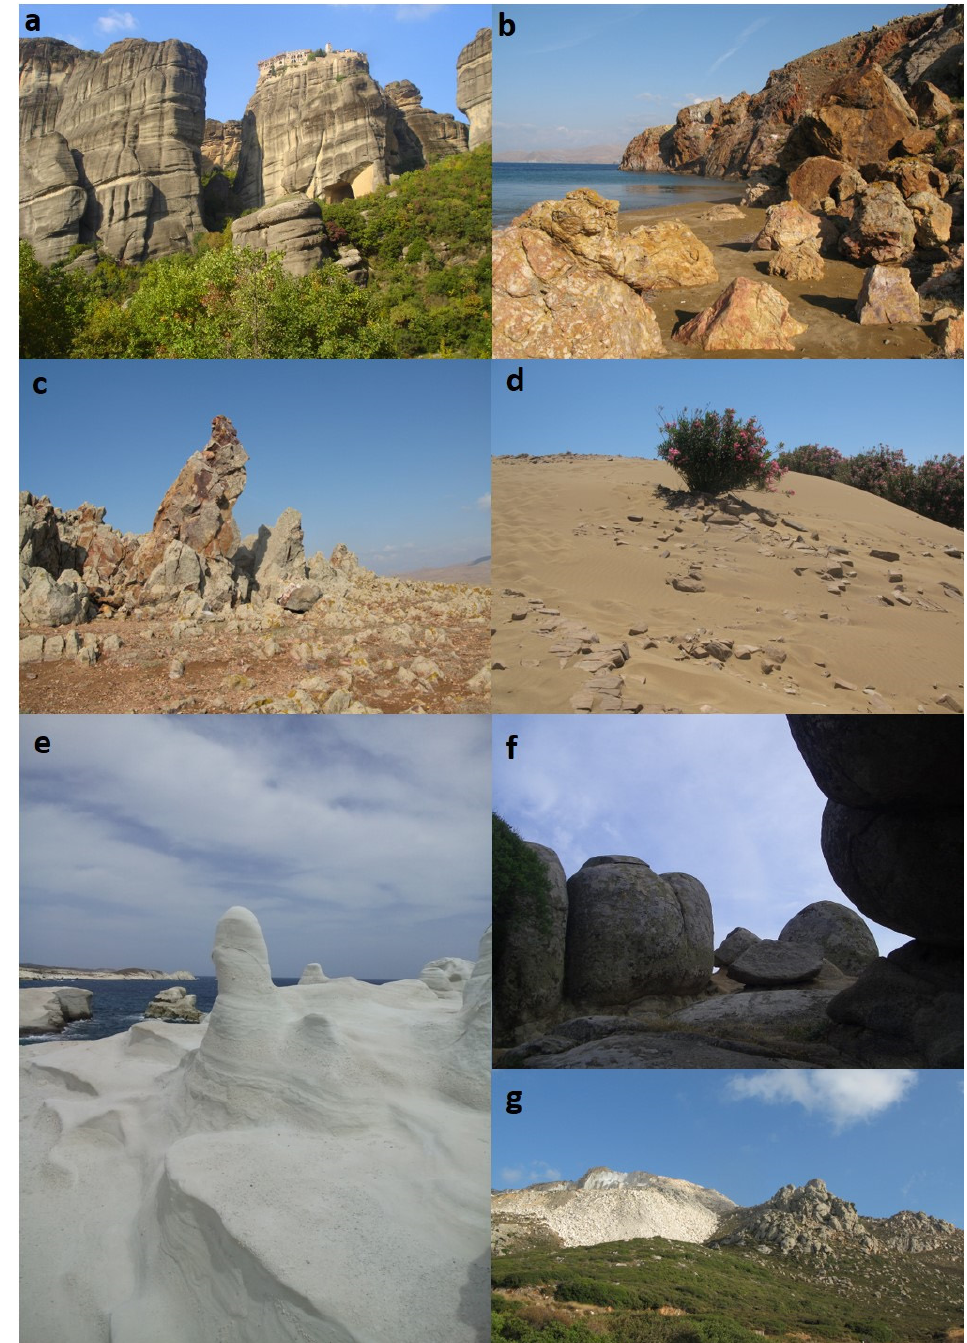
Figure 6. Selection of some representative geotopes of Greece. ( a ) Meteora geomorphes; ( b , c ) Limnos island, lavas in Fakos area; ( d ) Limnos island, weathered Oligocene sandstones; ( e ) Milos island, pumiceous pyroclastics; ( f ) spherical granites in Tinos island; ( g ) Naxos island, Migmatinte and Kinidatos marbles (personal photo archive P. Voudouris, H. Drinia).